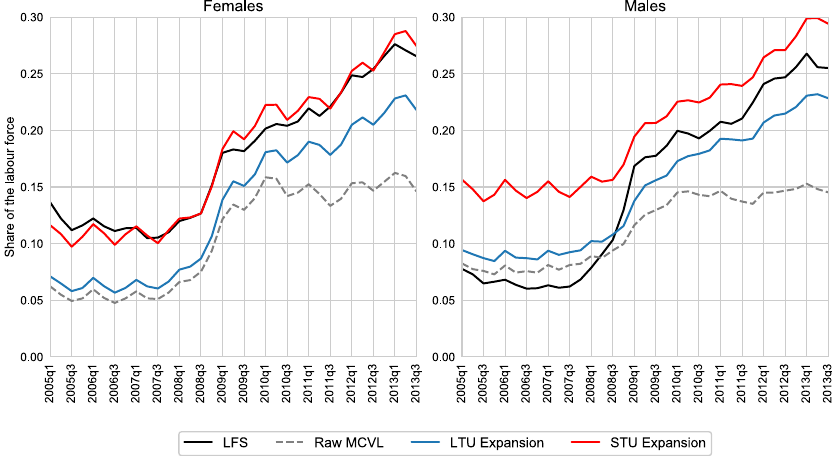
Fig. 9 Unemployment rates by gender. Source : MCVL and the